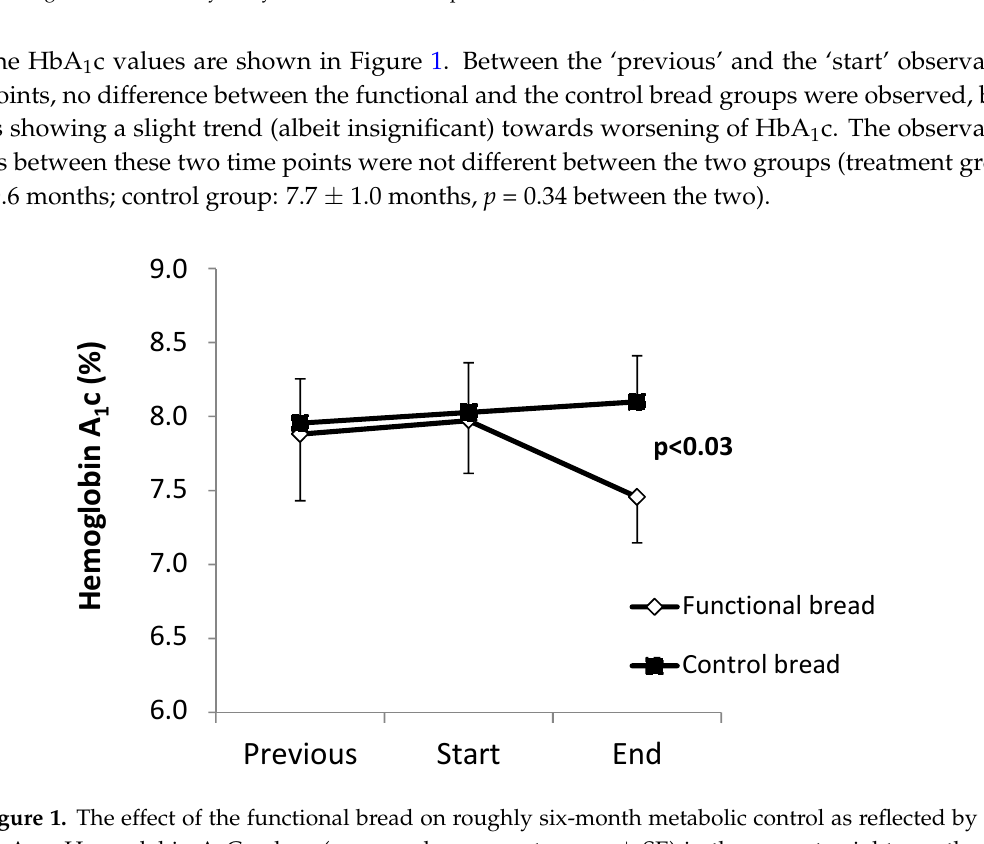
Figure 1. The effect of the functional bread on roughly six-month metabolic control as reflected by HbA 1 c. Hemoglobin A 1 C values (expressed as percent, mean ± SE) in the seven to eight months before (‘previous’), at the beginning (‘start’) and after six to seven months (‘end’) of intake of either the functional bread (open symbols) or the control white bread (filled symbols). The data are expressed as mean ± SE. The p value in the figure indicates the significant difference in the changes of HbA 1 c % values, before and following the intake of between either the functional bread or the control bread (by ANOVA).